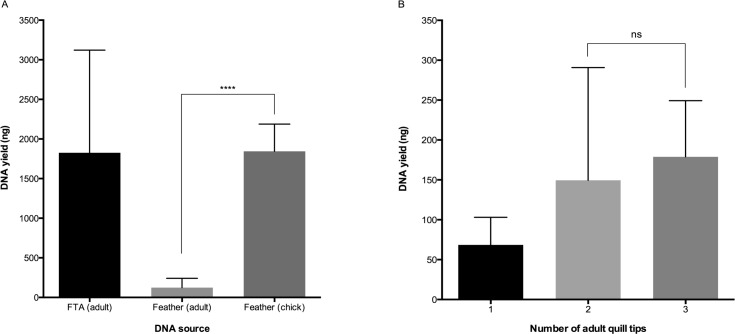
DNA yield varies with tissue source and age.A: Genomic DNA was isolated from blood stored on FTA cards (n = 132) and feather quill tips adult (n = 58) and chick (n = 6). DNA yield from adult feathers was significantly lower than chicks. B: The isolation of sufficient genomic material for experimental optimisation, bisulphite treatment and methylation analysis increases with the number of adult feather quill tips included in the extraction solution.